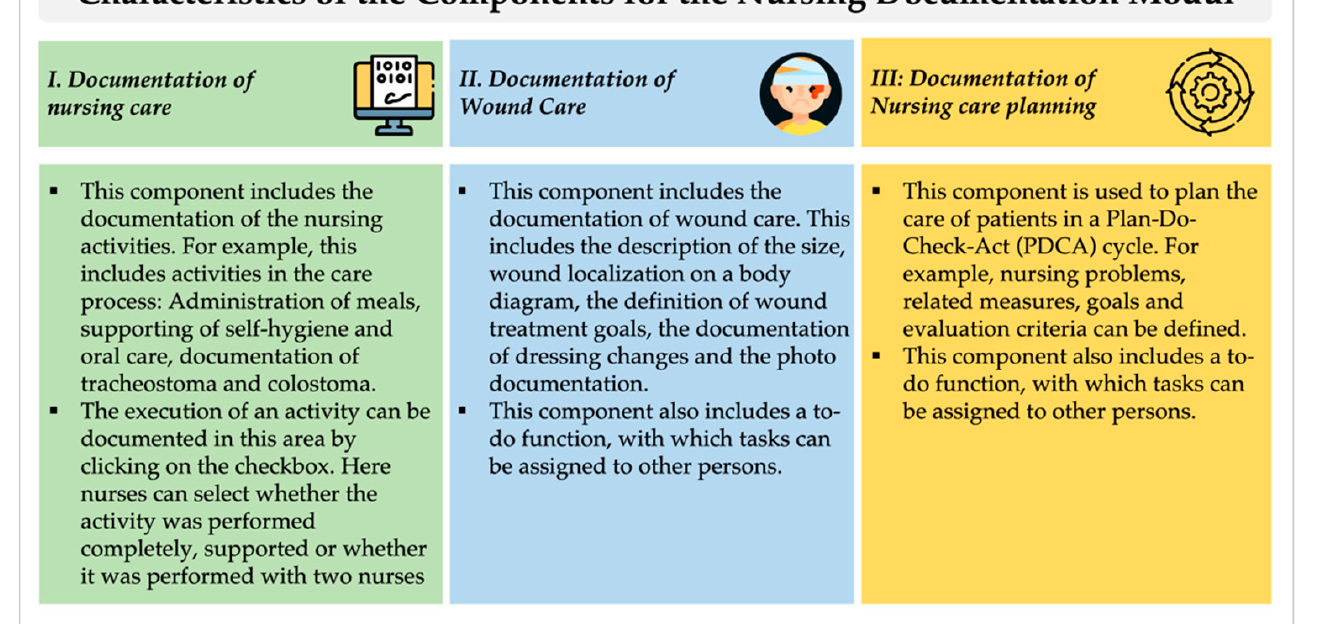
Figure 1. Overview of the characteristics of components for the nursing documentation module. (Icons made by Freepik from www.flaticon.com, accessed on 28 November 2021).